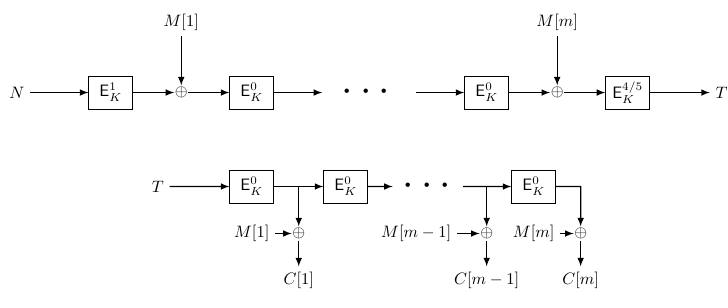
Figure 13: ESTATE with empty AD and m message blocks